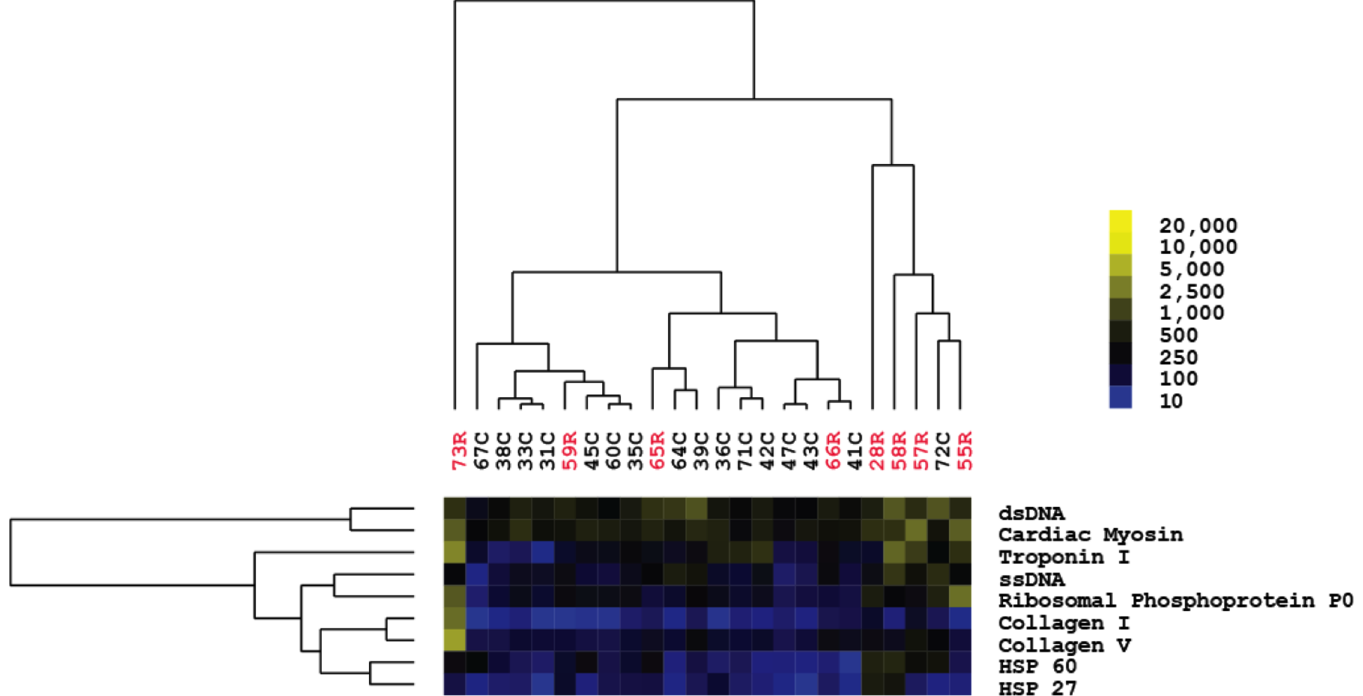
Fig 4. Heatmap showing reactivities that are higher in pre-transplant serum from rejectors compared with non-rejectors. Rejectors are indicated in red. Significant differences between rejectors and non-rejectors were detected with the SAM algorithm with q value < 0.05. Four of the rejectors are grouped together at the right of the heatmap and the rejector with the highest reactivities is in a separate group at the left. Scale shows reactivity from low (blue) to high (yellow). Results are representative of two independent array experiments. dsDNA, double-stranded DNA; Hsp60, heat shock protein 60; Hsp27, heat shock protein 27; ssDNA, single-stranded